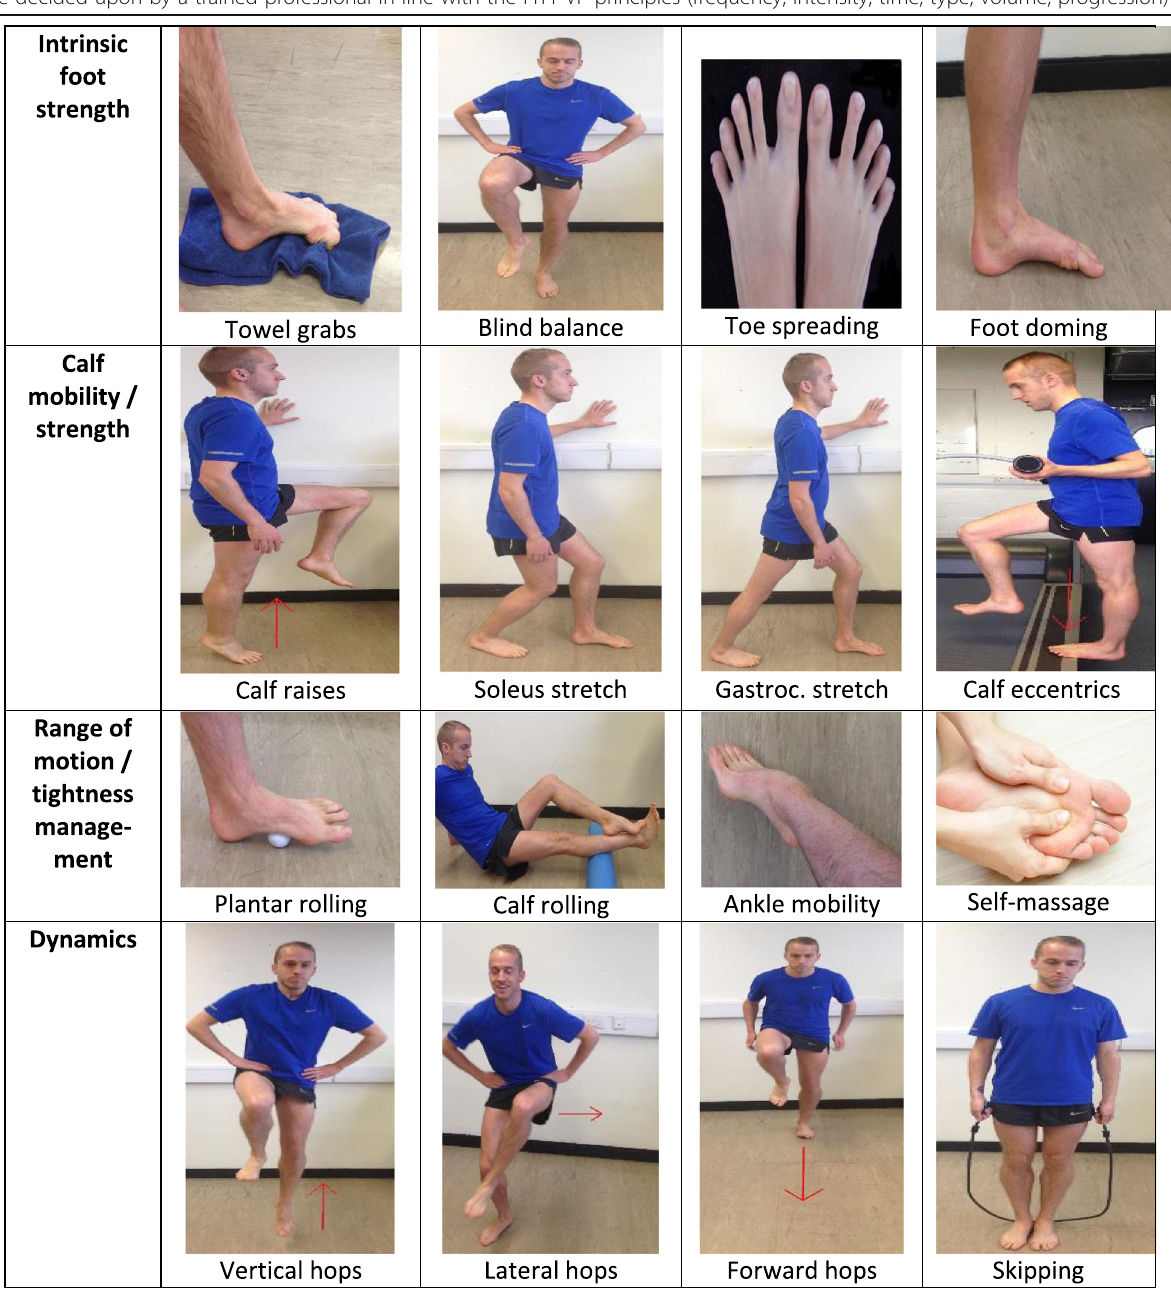
Table 4 Simple injury prevention exercises suggested for a minimal footwear transition. Note that these exercises require systematic evidence for their role in reducing injury risk. Exercises should be included several times a week, and the dynamic exercises should only be included after a minimum of 2 weeks due to the increased load and plyometric nature of these exercises. Sets/reps should be decided upon by a trained professional in line with the FITT-VP principles (frequency, intensity, time, type, volume,